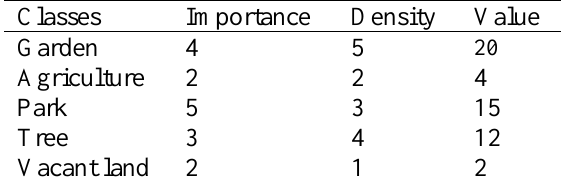
Fig. 2. GIS, school locations, and their 50-m buffer Table 1. Results of scoring GI classes in cognitive